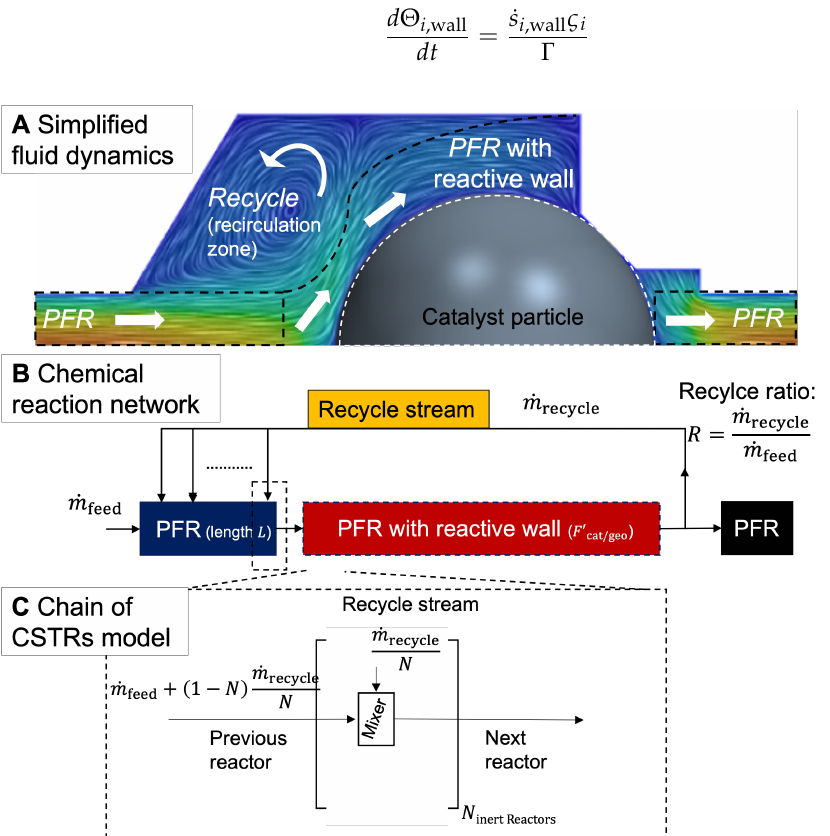
Figure 2. ( A ) Simplified fluid dynamics of one Temkin chamber and ( B ) the resulting CRN with a combination of PFRs and CSTRs. ( C ) Details on the chain of the CSTRs model. Back-mixing occurs only in the first PFR, where no reaction takes